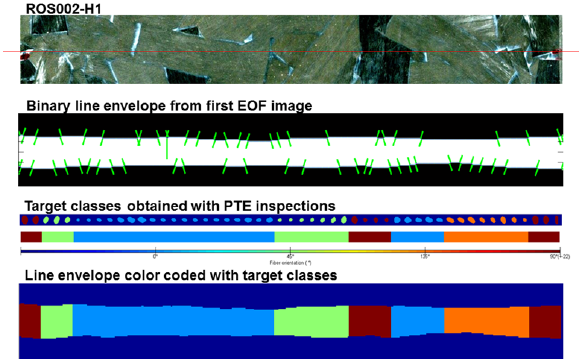
Figure 6. Class assignment of a line inspection. The line was divided into 49 samples and for